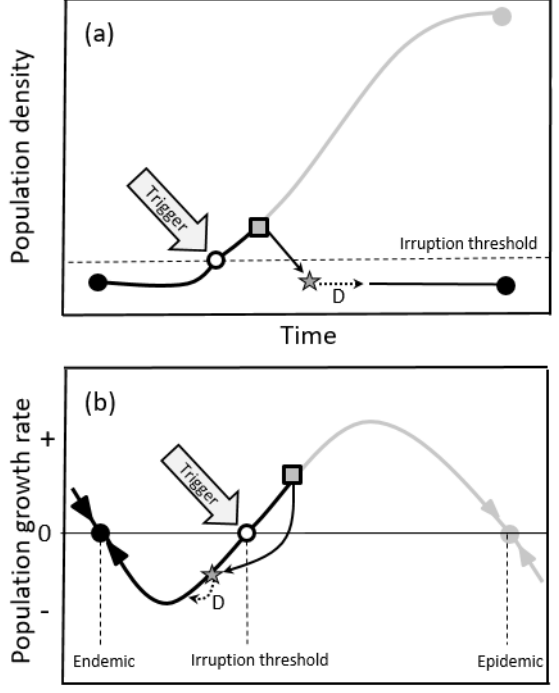
Figure 2. Hypothetical population trend ( a ) and recruitment curve ( b ) for rising spruce budworm populations under the ‘double-equilibrium’ hypothesis [26,27]. White circles represent the unstable irruption threshold, whereas the filled circles are stable. Gray boxes represent the starting point of a control treatment (e.g., with an insecticide), with its potential impacts on population density or growth rate indicated by stars, followed by expected population responses. Under this dynamic, sufficient treatment mortality (i.e., that is additive to natural mortality) may return populations to the lower equilibrium (dotted lines, grey stars), where depensatory pressure (‘D’) may keep populations